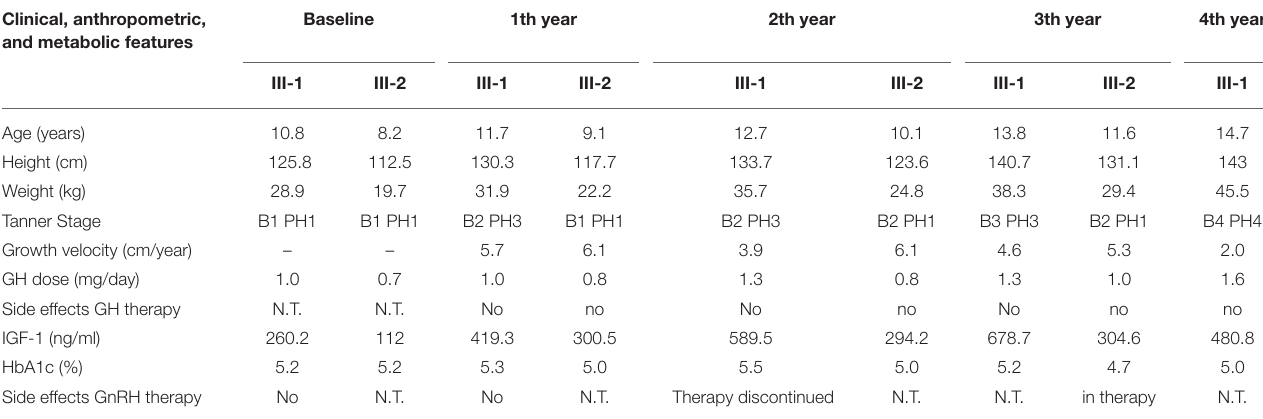
TABLE 2 | Clinical, anthropometric, and metabolic features at baseline and during GH treatment. Clinical, anthropometric, and metabolic